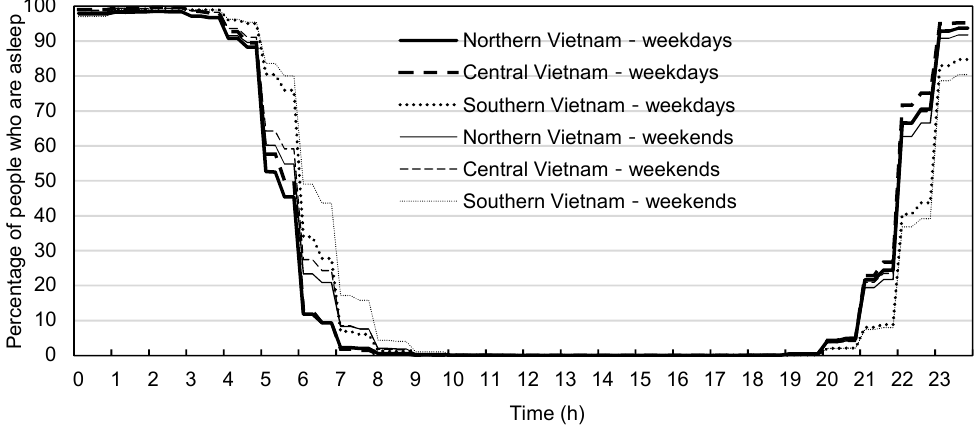
Figure 4. Vietnamese people’s sleeping temporal pattern by region (northern, central, and southern Vietnam).